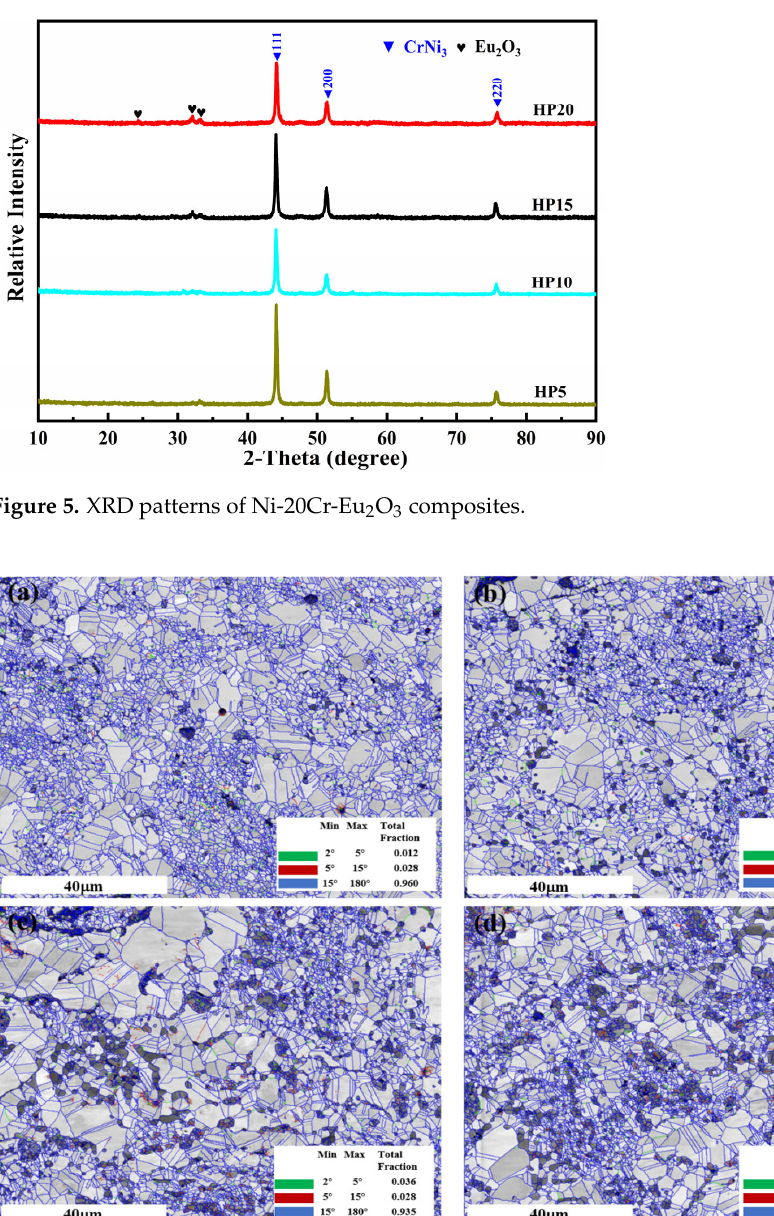
Figure 6. Grain information of the composites associated with ( a ) HP5; ( b ) HP10; ( c ) HP15; ( d ) HP20.